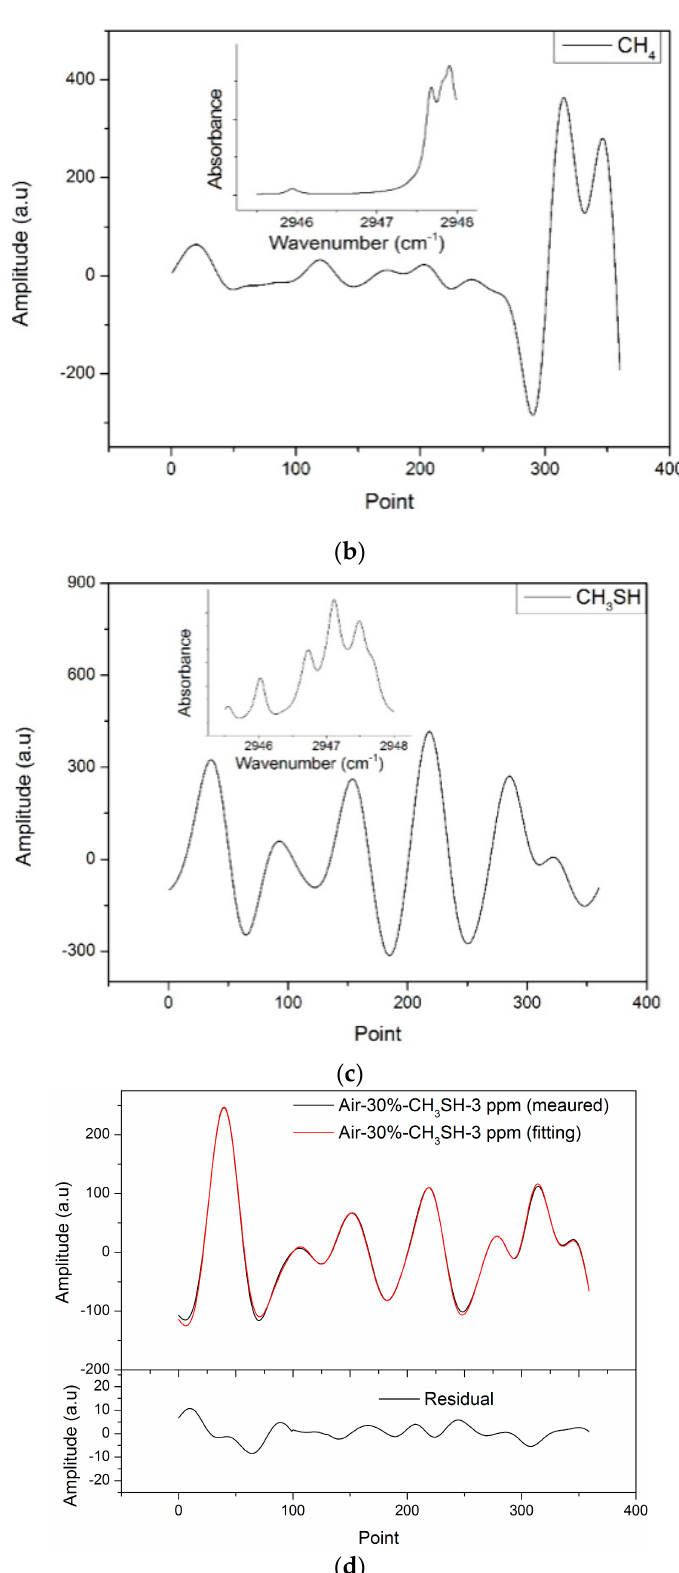
Figure 4. ( a ) The measured 2f reference signal of H 2 O. The inset is the absorption spectrum of H 2 O in 2945.5–2948 cm − 1 ; ( b ) The measured 2f reference signal of CH 4 . The inset is the absorption spectrum of CH 4 in 2945.5–2948 cm − 1 ; ( c ) The measured 2f reference signal of CH 3 SH. The inset is the absorption spectrum of CH 3 SH in 2945.5–2948 cm − 1 ; ( d ) The measured and simulated 2f signals of the mixture (air-30%-CH 3 SH-3 ppm) and the residual between them.